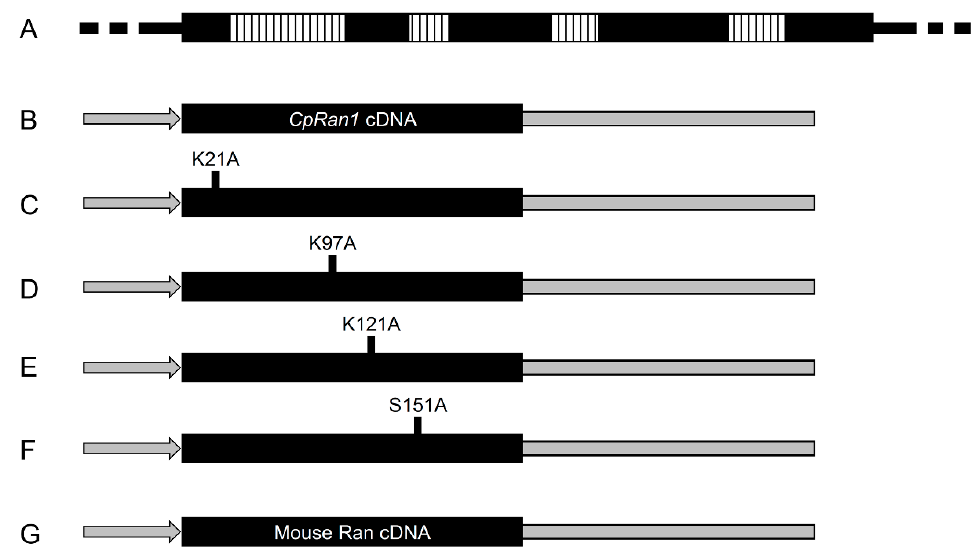
Figure 8. Schematic representation of the complementing vectors. ( A ) Full-length genomic DNA of the CpRan1 gene was used as a control; vertical dashed lines in the genomic DNA represent introns. ( B – F ) A series of vector constructs containing various point mutations of CpRan1 were constructed using cDNA of the CpRan1 gene and an expression cassette consisting of a strong constitutive cryparin promoter (p188) and trpC terminator. ( G ) A cDNA clone of Ran gene from mouse (GenBank No. AAH83356.1) was used for the heterologous expression. Table 1. Numbers of transformants using various complementing CpRan1 vectors on different selection media and num- bers of resulting hygromycin B-resistant transformants used for spore harvesting and single-spore analysis.